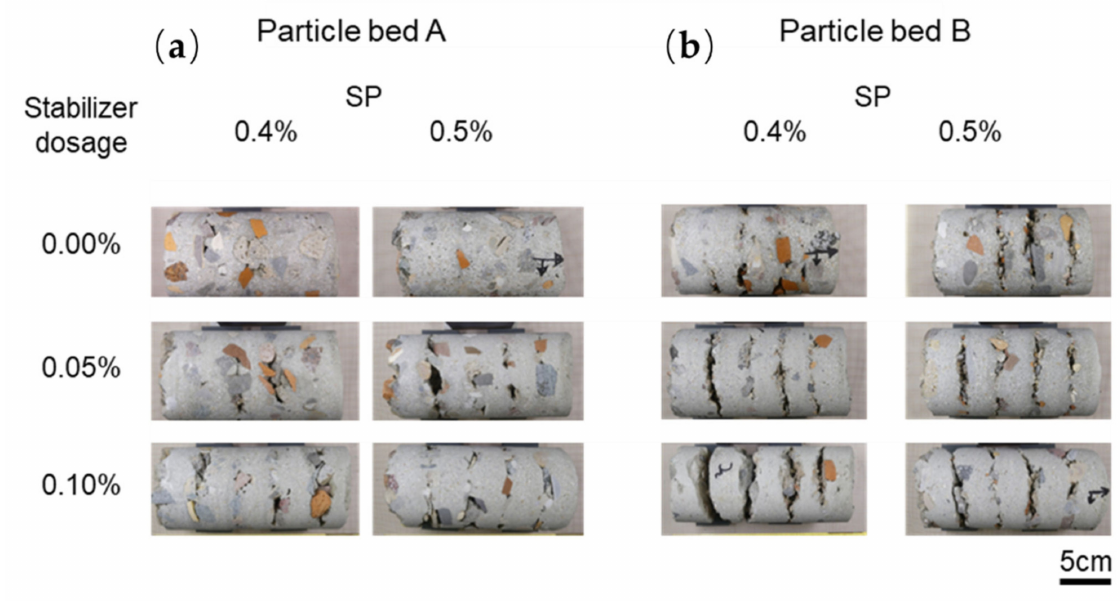
Figure 7. LC3DCP drilling cores with 5 layers from particle bed A ( a ) and B ( b